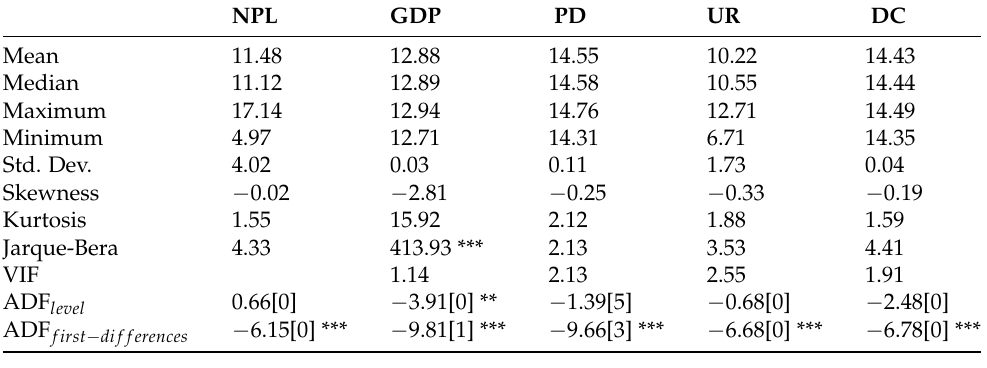
Table 2. Summary statistics. Notes: **, and *** indicate 5%, and 1% significance level.